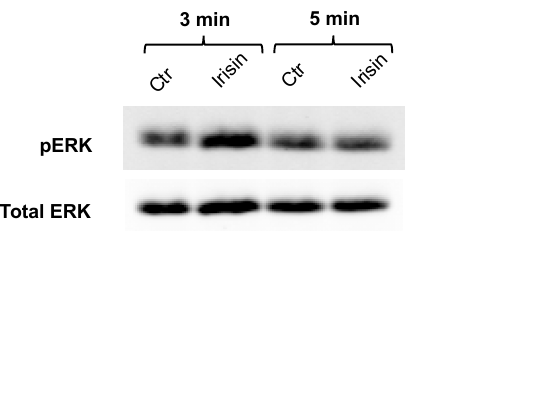
Figure 1. Effects of irisin on extracellular signal-regulated kinase (ERK) phosphorylation (pERK) in DBSCs cultures. Dental bud stem cells (DBSCs) were stimulated with irisin for the indicated time points. Phosphorylated and total ERK expression levels in cell lysates were examined by Western blot and measured with corresponding densitometry band quantification. Densitometric analysis is expressed as the relative optical density (OD) of the bands normalized to total ERK. The graph shows that the treatment significantly, but transiently, increased the protein expression level of pERK after 5 and 7 min of stimulation. The graph represents data as a boxplot with median and interquartile ranges of n = 3 independent experiments. * p < 0.05, **** p < 0.0001. Statistics: unpaired Student’s t -test.